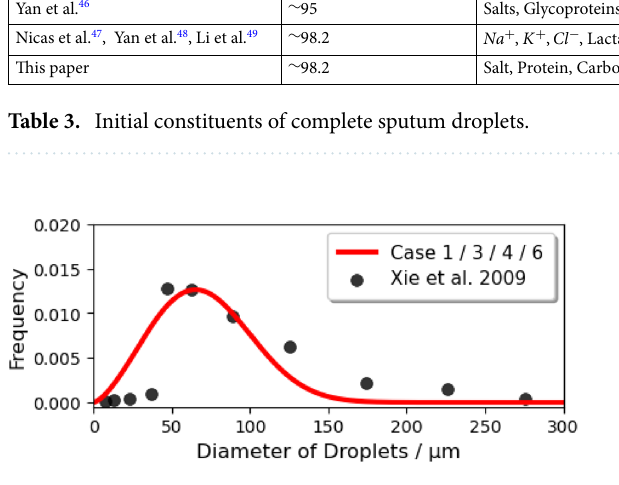
Figure 8. Initial saliva droplets size distribution (ranging from 1 to 300 micrometer).